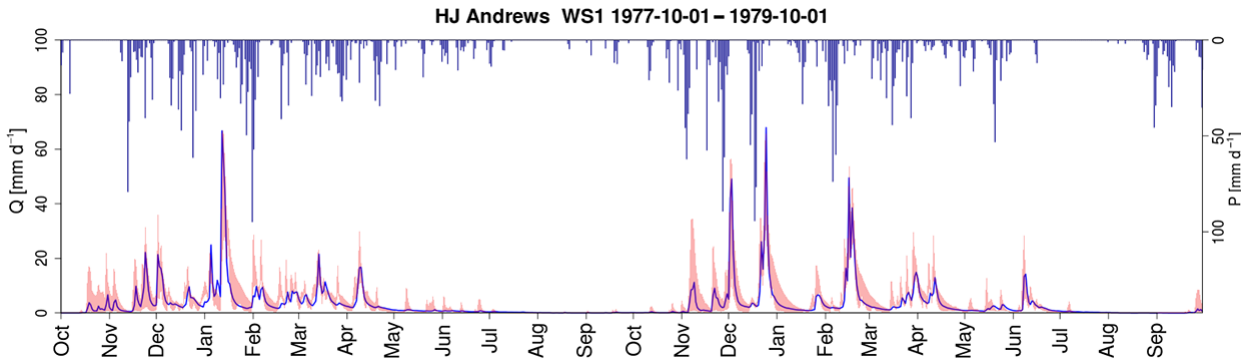
Figure 5. Observed and modelled hydrograph for HJ Andrews WS1 for the years of 1978 and 1979, with the red coloured area indicating the 5 / 95% uncertainty intervals of the modelled discharge. Blue bars show daily